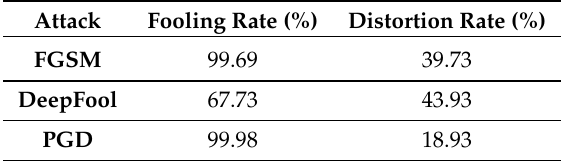
Table 4. Fooling and average distortion rate of each adversarial attack